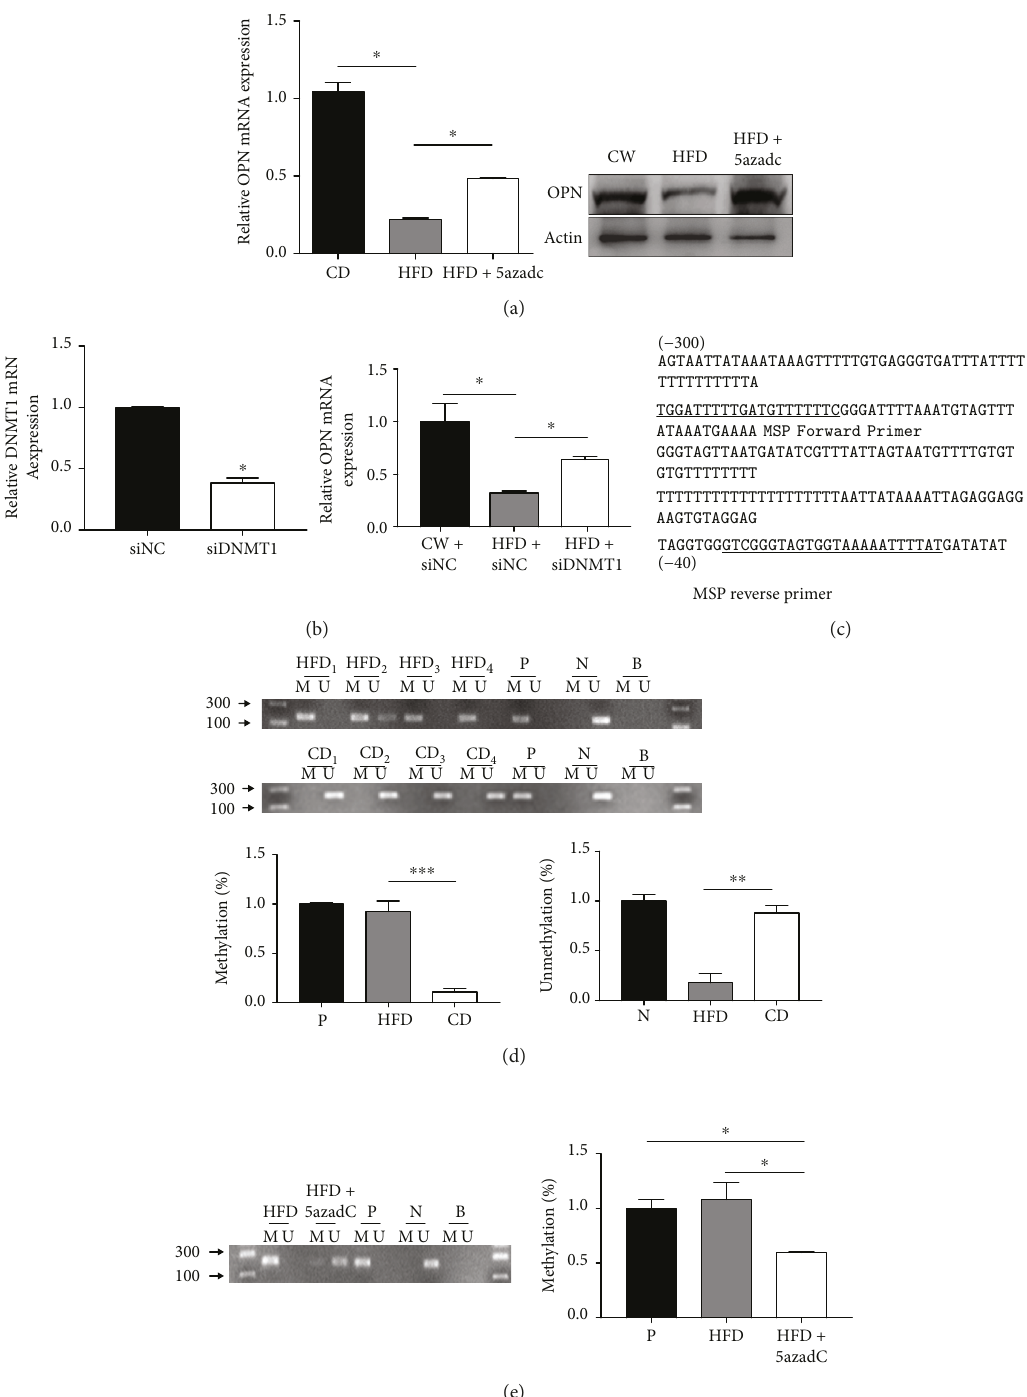
Figure 2: The methylation of the OPN promoter inhibits the transcription of OPN. (a) ASCs from HFD mice treated with 5 μ mol 5 ′ -aza-2 ′ dC (HFD+5 ′ -aza-2 ′ dC) for 2 days related to untreated (HFD) and control (CD) cells was determined by real-time PCR and western blot analysis. (b) E ff ect of siDNMT1 treatment on the relative abundance of transcript levels of DNMT1 and OPN. (c) Relative location for primers of MS-PCR. (d) MS-PCR analysis of OPN in ASC lines from CD and HFD mice. Same amount of DNA was ampli fi ed with primers speci fi c to the unmethylated (U) or the methylated (M) CpG sites of the OPN gene after modi fi cation with sodium bisul fi te. Methylation or unmethylation percentage in ASCs have been quantitated by ImageJ (National Institutes of Health) with normalization to positive (P) or negative (N) control. (e) MS-PCR analyzed the methylation patterns of OPN promoters in ASCs after treatment with 5 ′ -aza-2 ′ dC for 2 days. The schematic showed the methylation percentage in response of 5 ′ -aza-2 ′ dC treatment. P, methylated DNA; N, unmethylated DNA; B, blank control. Values are means ± SEM. ∗ P < 0 05 ; ∗∗ P < 0 01 ; ∗∗∗ P < 0 001 . All experiments were repeated at least